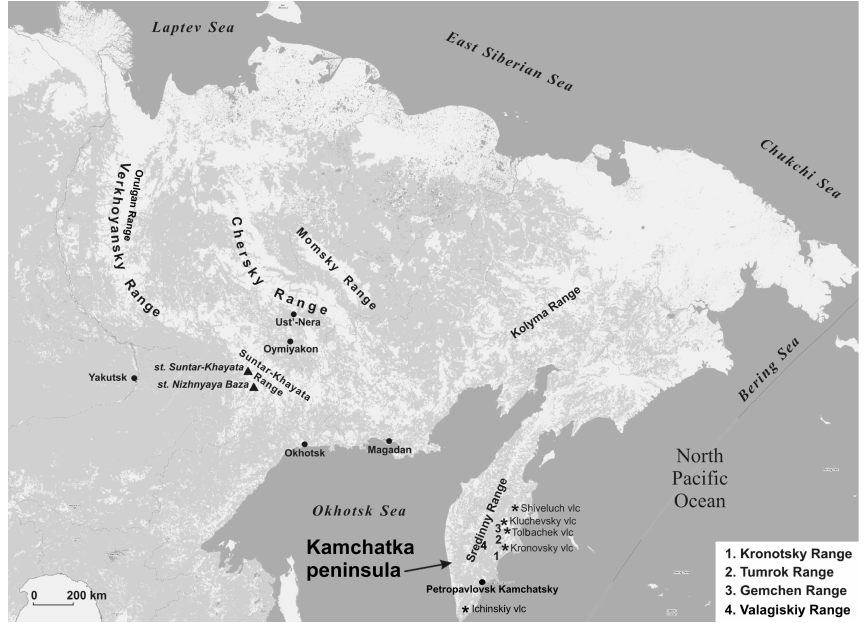
Fig. 1. Map of the study